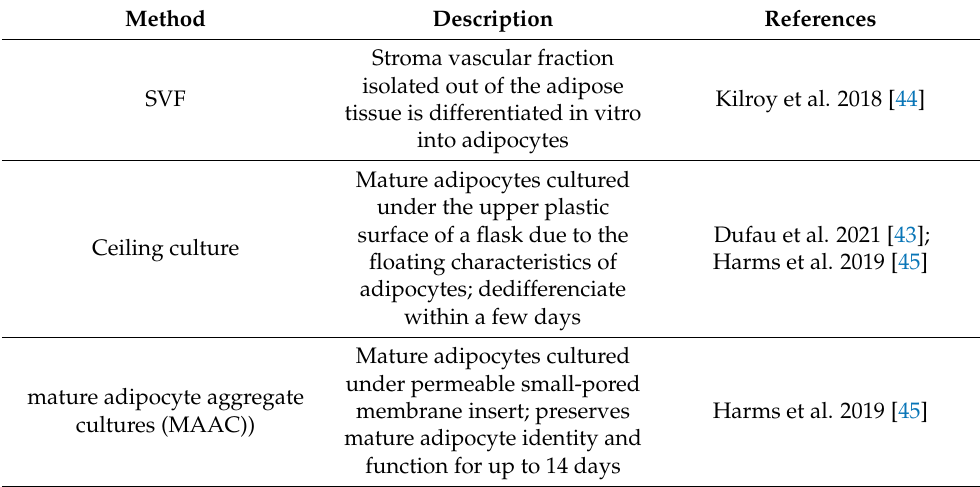
Table 1. Overview of different in vitro methods to culture